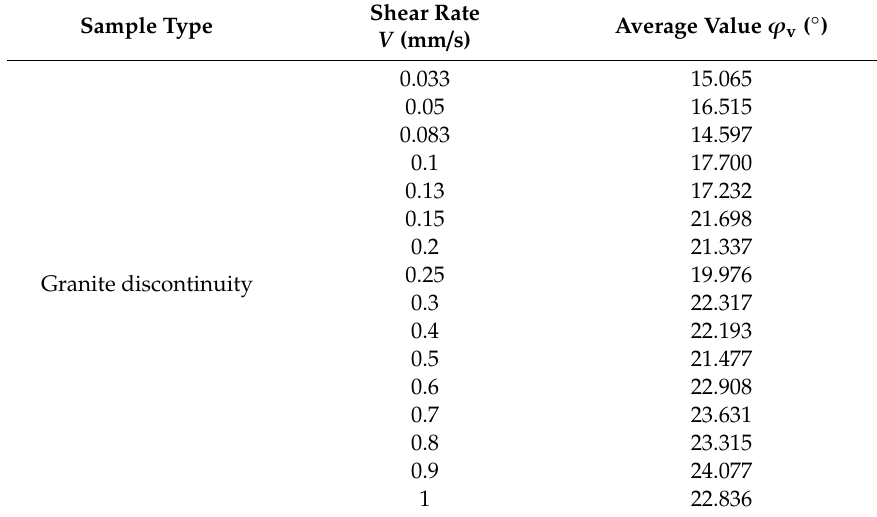
Table A3. Average values of rate-dependent friction angle ϕ v for di ff erent granite discontinuity samples with the shear rate varying from 0.03 mm / s to 1 mm / s.